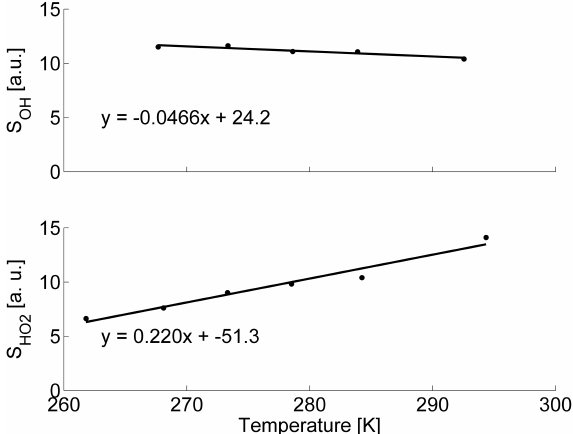
Fig. 7. A calibration at different temperatures was conducted to study the effect of temperature-dependent surface losses of HO 2 within the inlet and detection system of HORUS under upper tropo- spheric conditions. Here the signal S , which is normalized to laser power and time, is shown as a function of